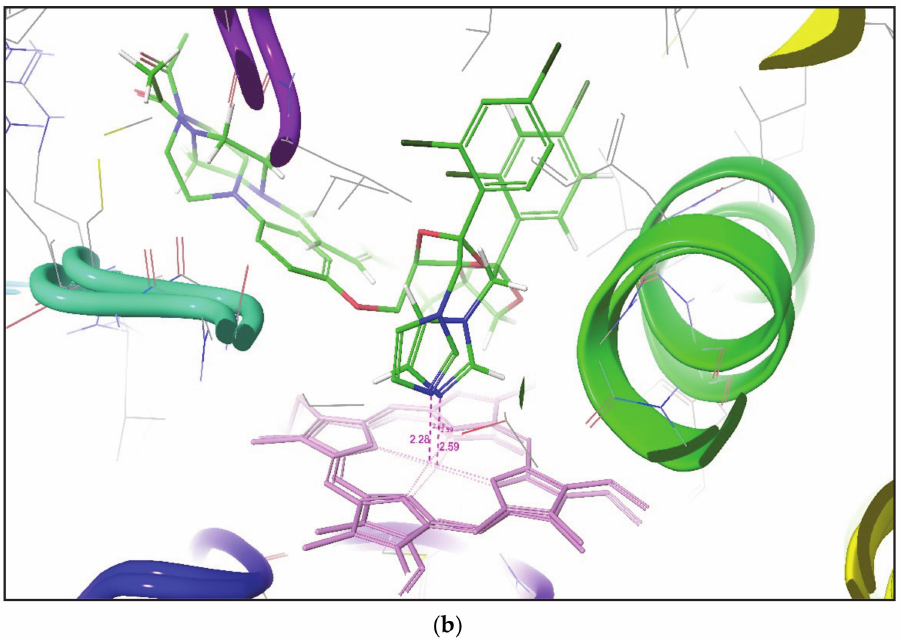
Figure 2. Superimposition of the pose of ketoconazole docked in ( a ) PDB id 1TQN and ( b ) PDB id 2V0M by IFD over crystal structure of ketoconazole bound CYP3A4 (PDB id 2V0M). The pink dotted line indicates the distance between site of metabolism (SOM) and the Fe atom of